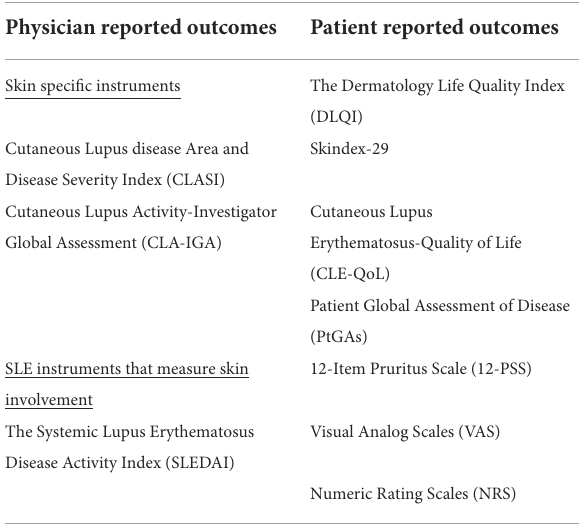
TABLE 1 Lupus outcome measurements. Outcome